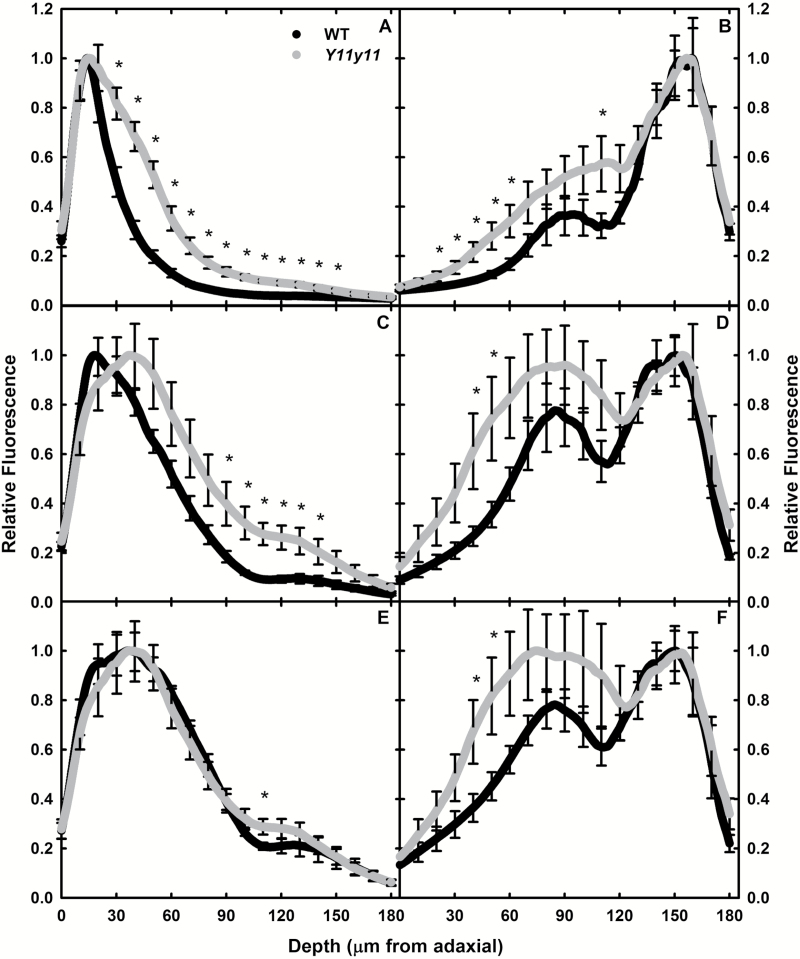
Relative fluorescence with distance from the adaxial surface. WT (black) and Y11y11 (grey) chamber-grown leaves were illuminated with blue (445nm; A, B), red (638nm; C, D), and green (561nm; E, F) lasers from the adaxial (A, C, E) and abaxial (B, D, F) surface using light sheet microscopy. Mean fluorescence (n=6) is shown every 0.23 µm. Error bars are indicated every 10 µm. Asterisks represent significant differences at P<0.05.